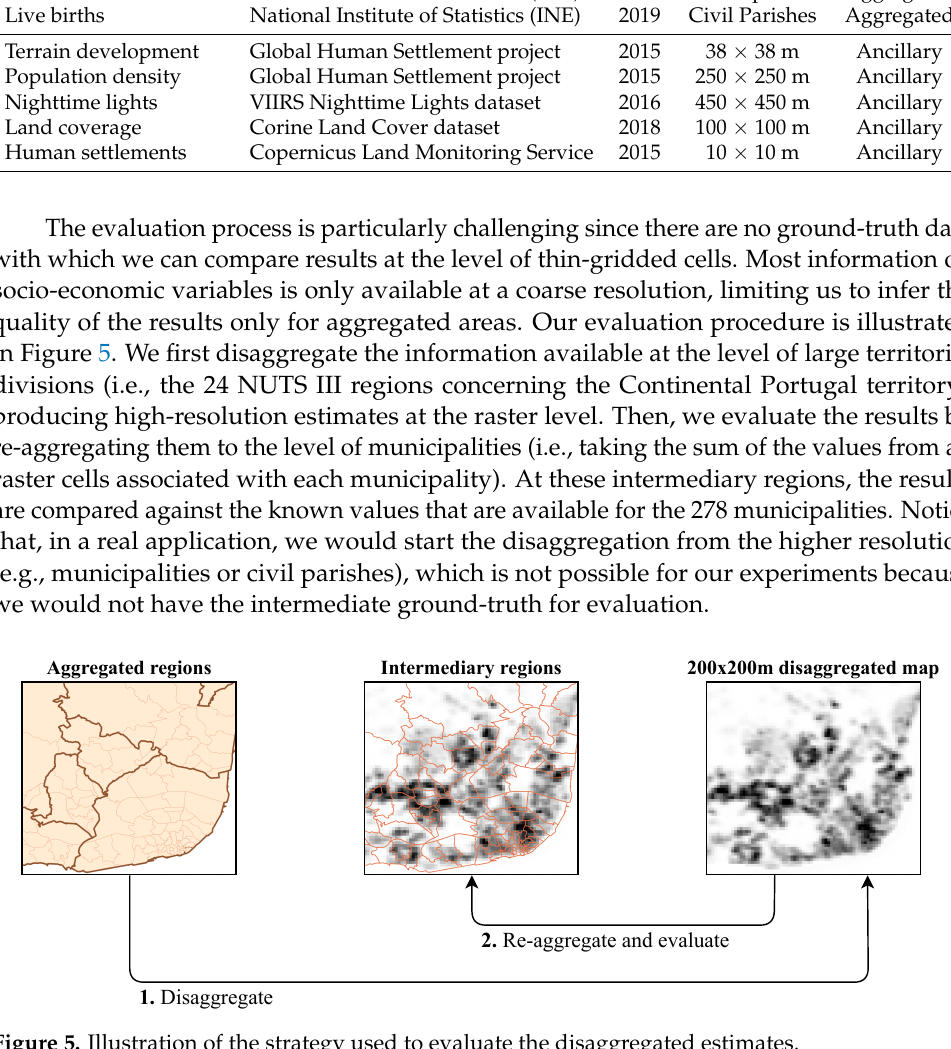
Figure 5. Illustration of the strategy used to evaluate the disaggregated